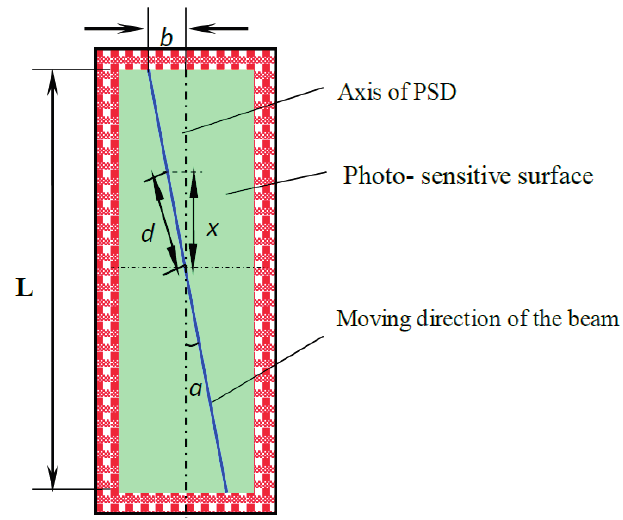
Figure 10. Beam positions on the PSD’s photosensitive